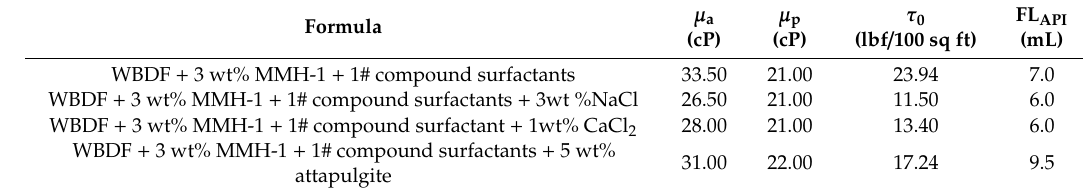
Table 9. Effect of drilling fluid on coal sample’s permeability. Table 10. Anti-pollution test